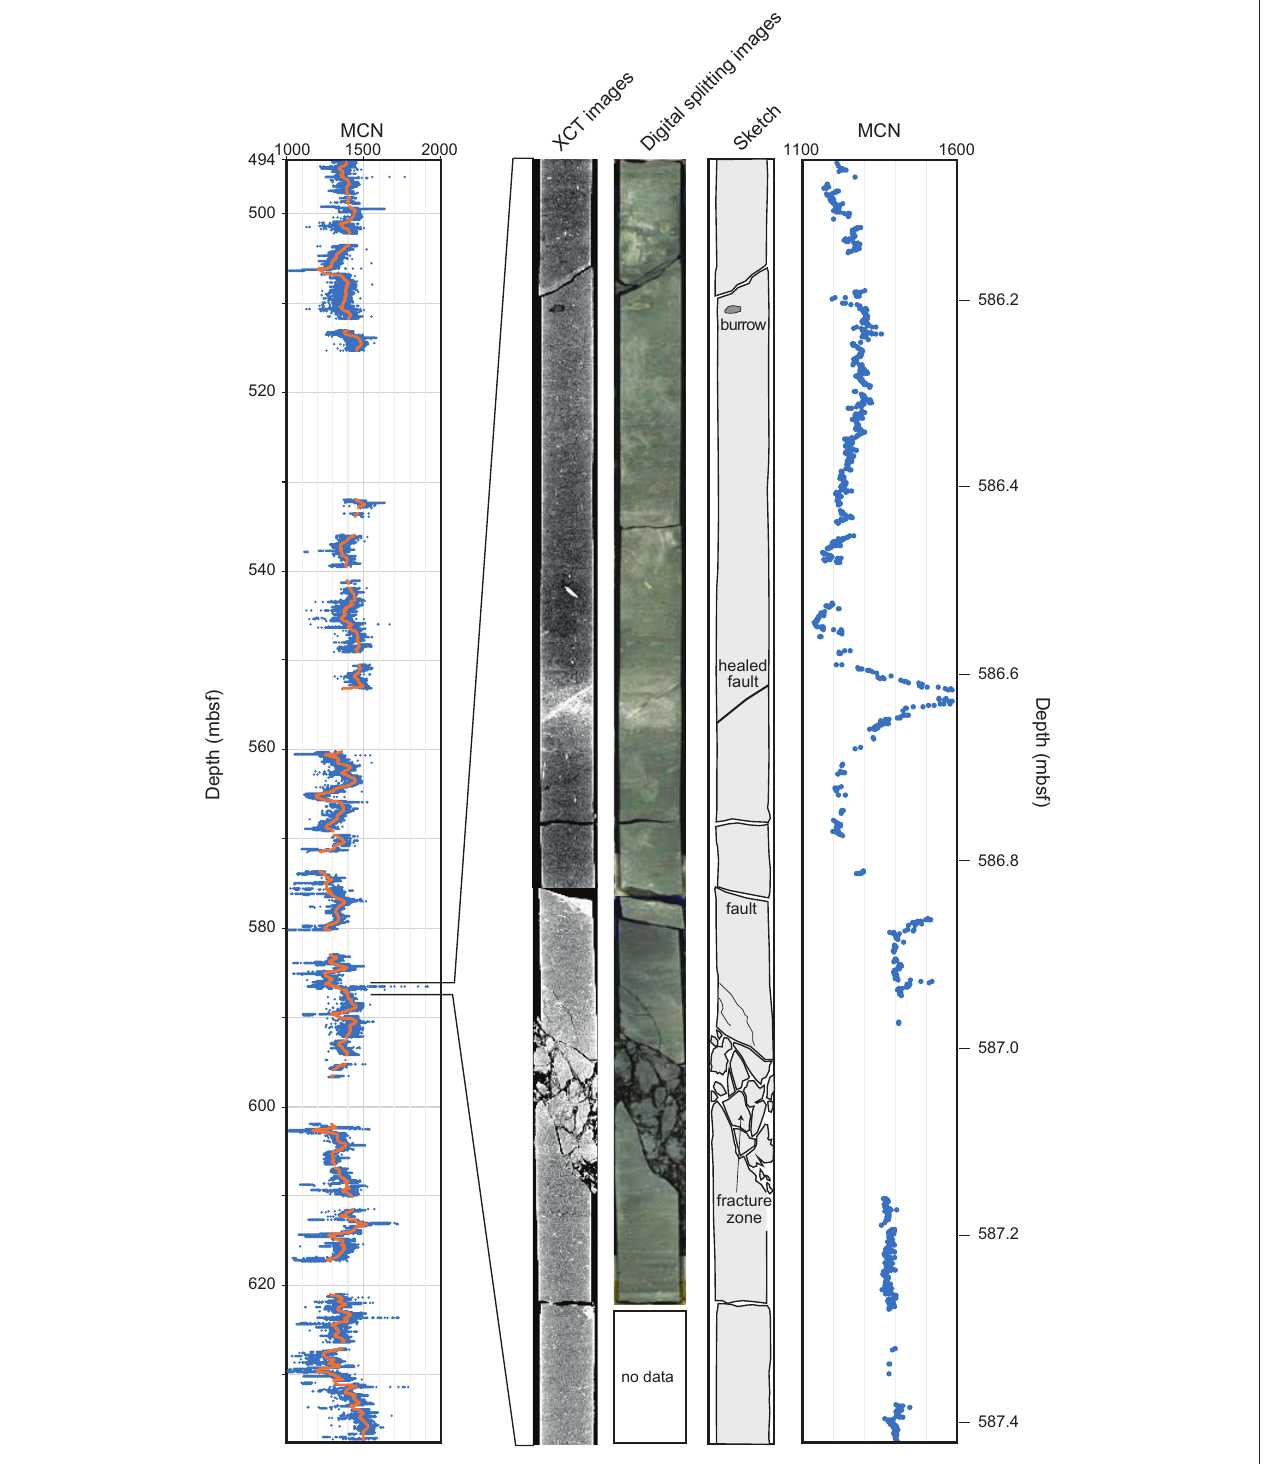
FIGURE 7 | Downhole quality-controlled MCN profile of the Upper Shikoku Basin facies (494.0–637.3 mbsf). Orange plots are 500-slices moving averages of MCN. XCT images, digital splitting images, a sketch and a close up MCN profile of an abrupt increase around a positive spike are shown (from core C0023A-36R-3, 64 cm to core C0023A-36R-4, 57